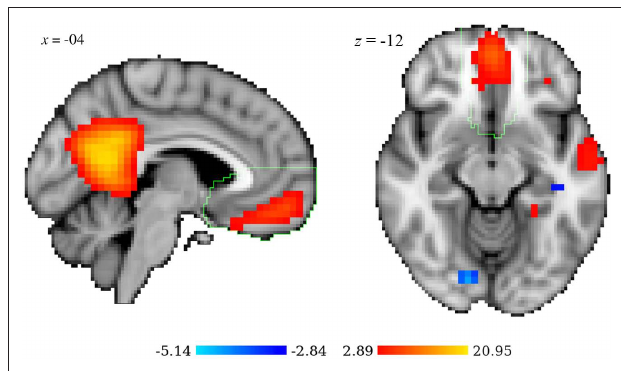
FIguRe 8 | Two views of the network that constitutes the independent component #24: sagittal ( x = − 04), and axial ( z = − 12). The vmPFC is outlined in green. Radiological convention. MNI152